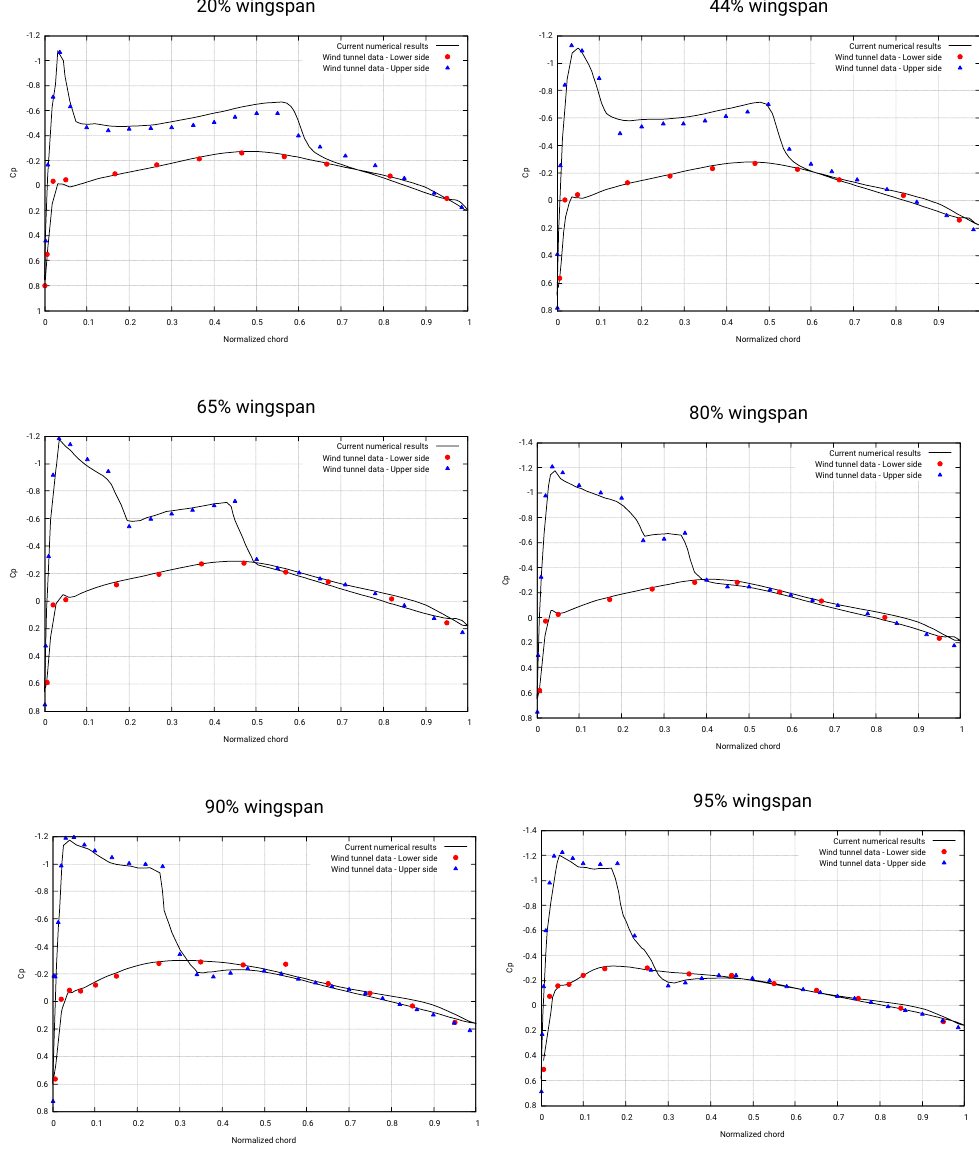
Figure 10. Plot of the pressure coefficient Cp on the wing surface at different sections. Comparison of numerical and experimental